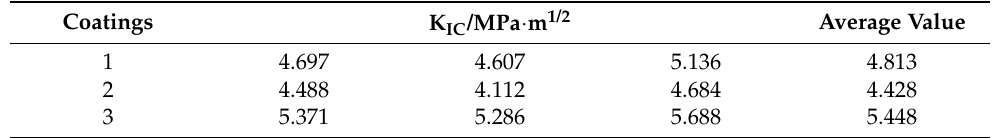
Table 4. The fracture toughness of the